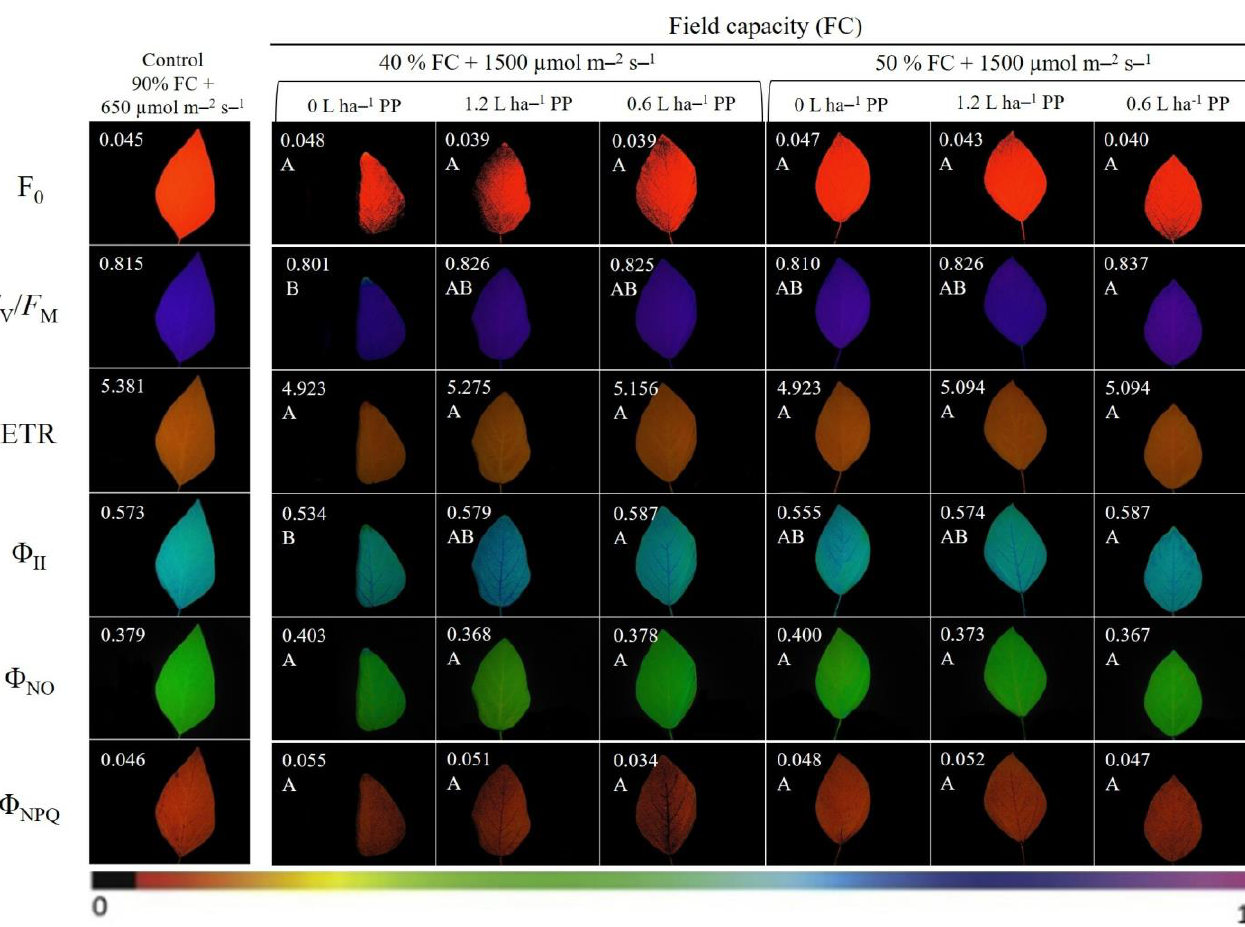
Figure 4. Initial fluorescence (F0), potential quantum yield of photosystem II (F V /F M ), apparent electron transport rate (ETR), effective quantum yield of photosystem II ( Φ II ), quantum yield of regulated energy dissipation ( Φ NPQ ), and quantum yield of unregulated energy dissipation ( Φ NO ) of soybean plants treated with doses of potassium phosphite (PP) and exposed to water deficit + high irradiance for 12 days. Means followed by the same letter did not differ among stress treatments, as determined by Tukey’s test ( p < 0.05). The false color code depicted at the bottom of the imagens rages from 0.0 (black) to 1.0 (pink). (For interpretation of the references to color in this figure legend, the reader is referred to the web version of this article.)